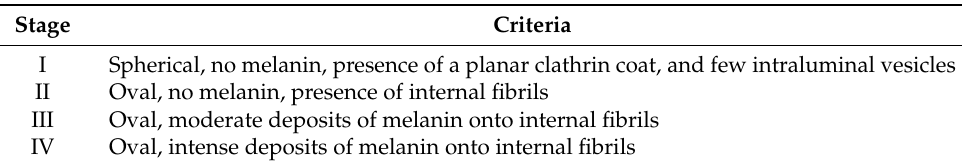
Table 2. Ultrastructural characteristics of melanosome stages.